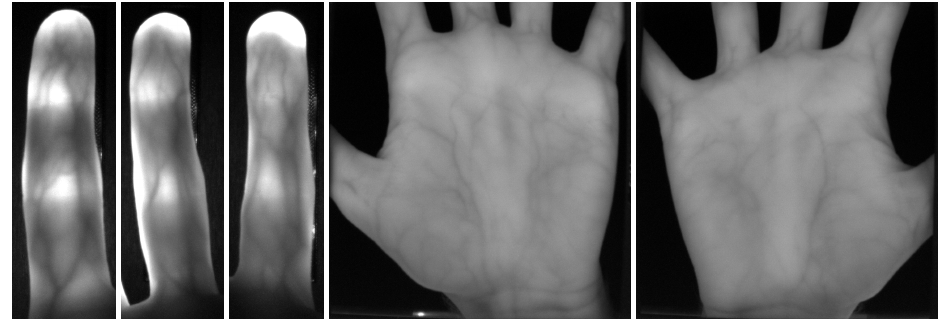
Figure 6. Example images of the PLUSVein-Contactless finger ( left ) and hand ( right ) vein